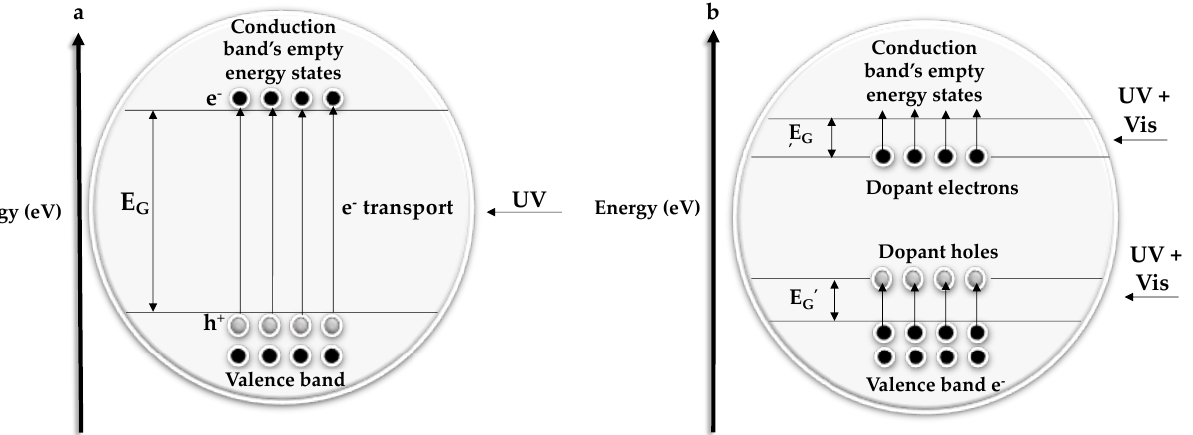
Figure 3. The effect of dopants on the band gap’s electronic structure and E G . ( a ) Band structure of pure titanium dioxide. ( b ) Formation of additional donor and acceptor energy levels as a result of doping. EG= energy gap. Adapted from reference [3].